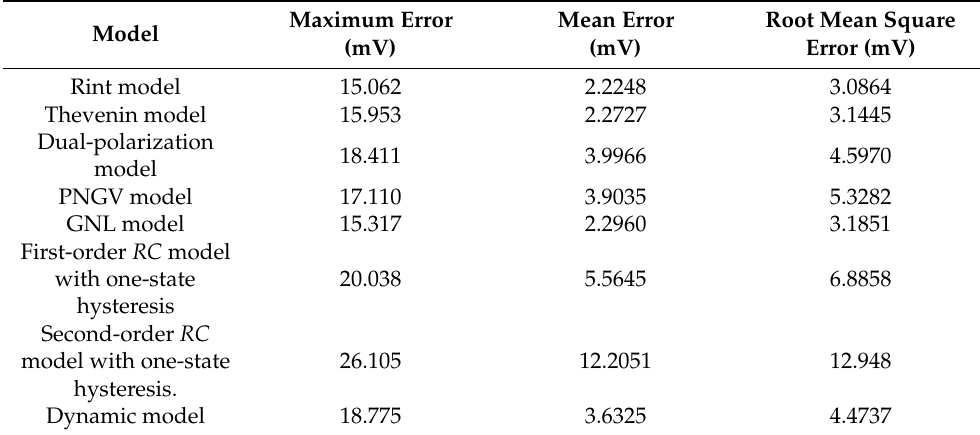
Table 3. Errors of the eight